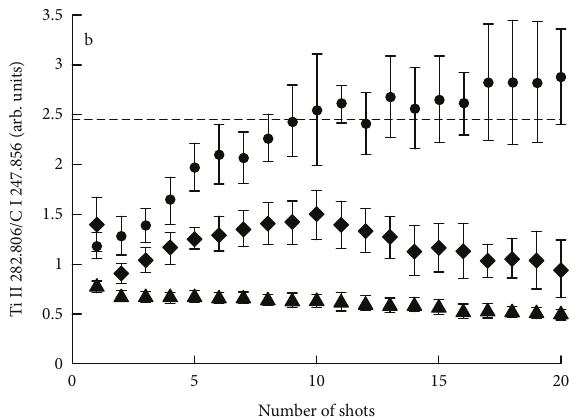
Figure 10: Evolution of the peak intensity ratio for Ti II 282.81nm/ C I 247.86nm on the thermally debound sample. The dashed line shows the sintering threshold. The di ff erent energies used were 200mJ ( ● ), 100mJ ( ♦ ), and 50 mJ ( ▲